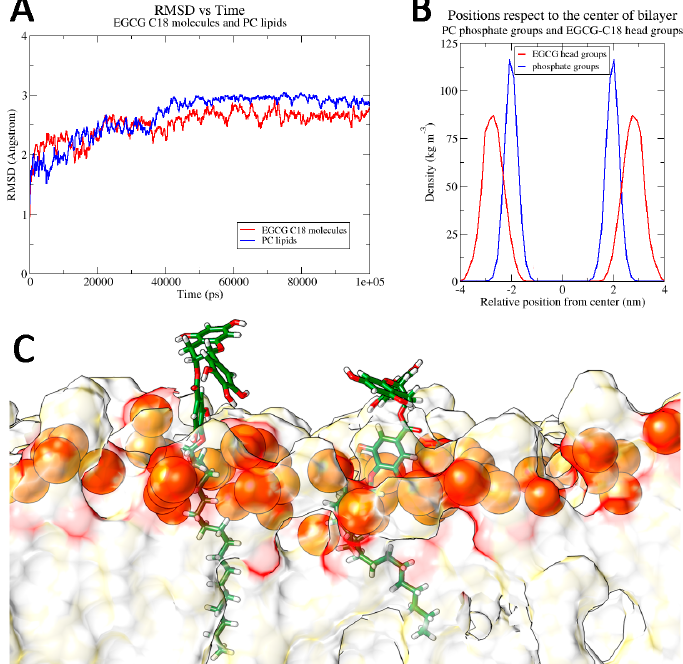
Figure 5. ( a ) Root Mean Square Deviation (RMSD) of C18-EGCG molecules and PC lipids in function of time. ( b ) Mass density profiles of C18-EGCG heads and phosphate groups respect to the center of simulation box. ( c ) C18-EGCG organization inside liposome vector. Results obtained from Molecular Dynamic Simulations.